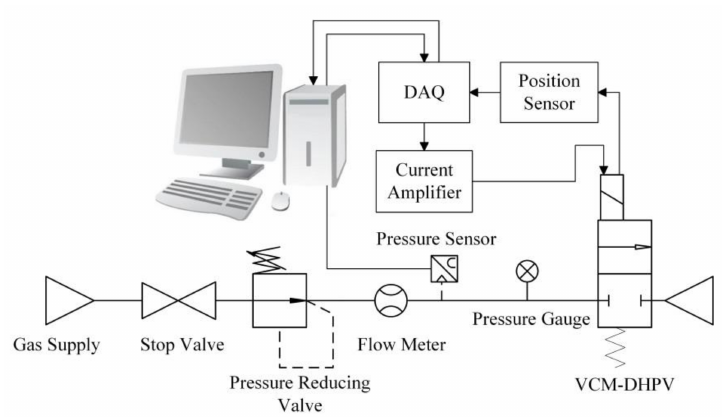
Figure 9. Schematic diagram of the pneumatic circuit test bench.